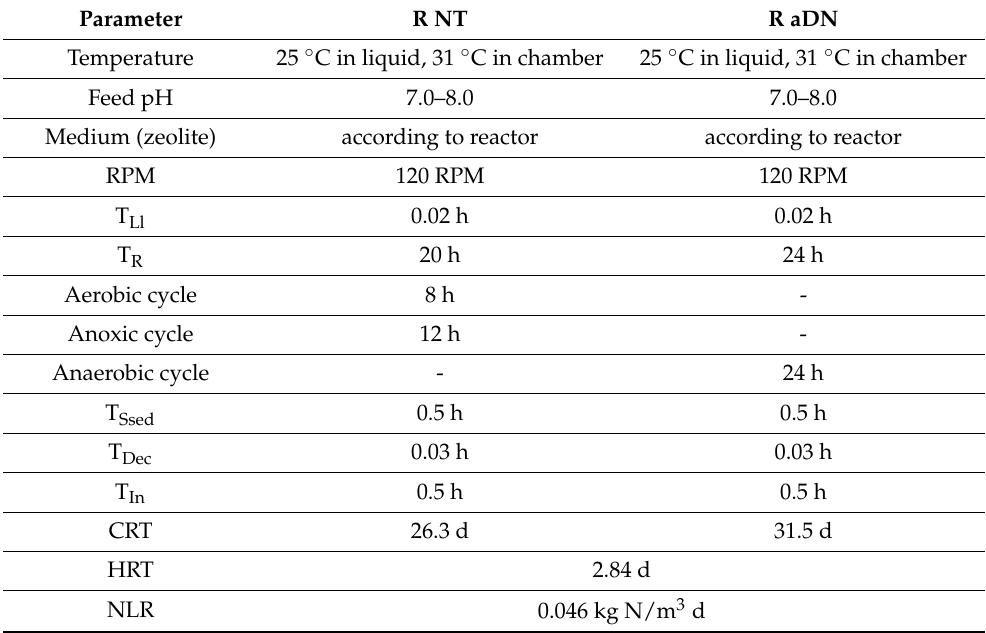
Table 4. Operating conditions for the sequential NTaDN